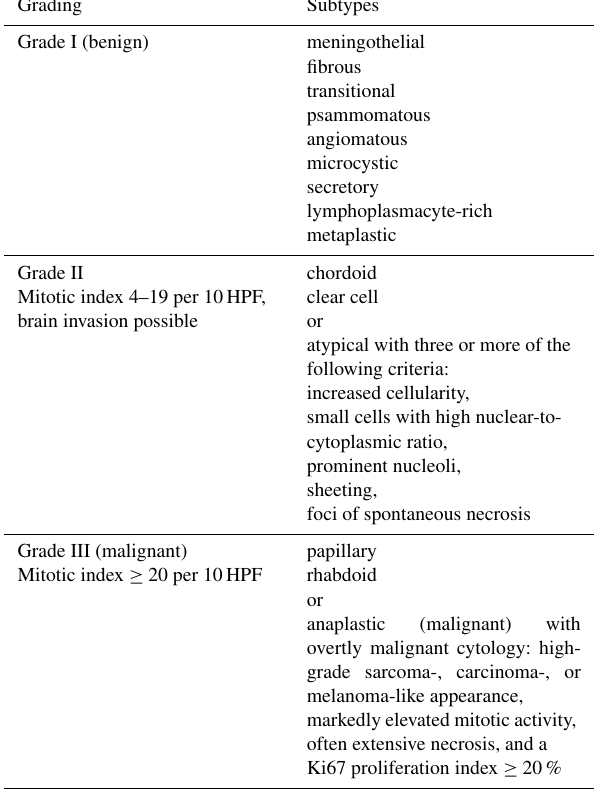
Table 1. The WHO classification of meningiomas (modified).